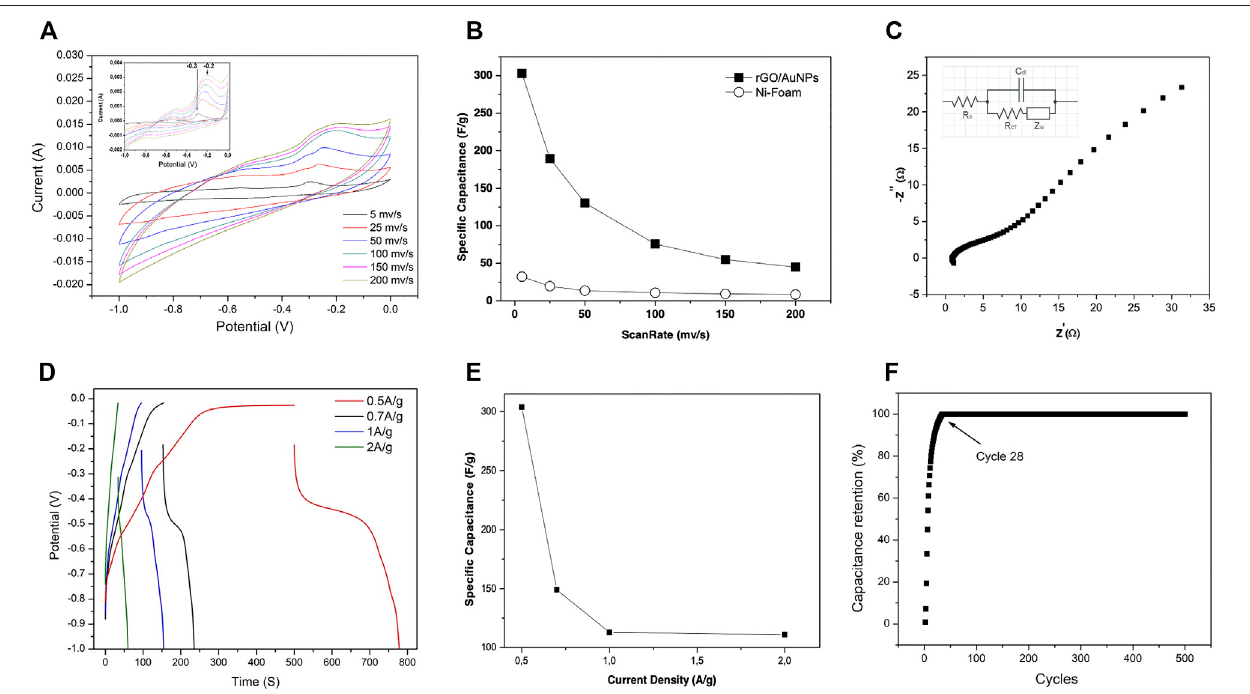
FIGURE5| Electrochemicalmeasurementofthegraphene-Au composite inthreeelectrodecon fi gurations. (A) CV curve. (B) Speci fi ccapacitance ofpureNifoam and rGO-Au composite atdifferentscanrates. (C) Nyquist plot. (D) Chargedischarge curveat differentcurrentsdensities. (E) Speci fi ccapacitancesatdifferentcurrents densities. (F) Capacity retention of the